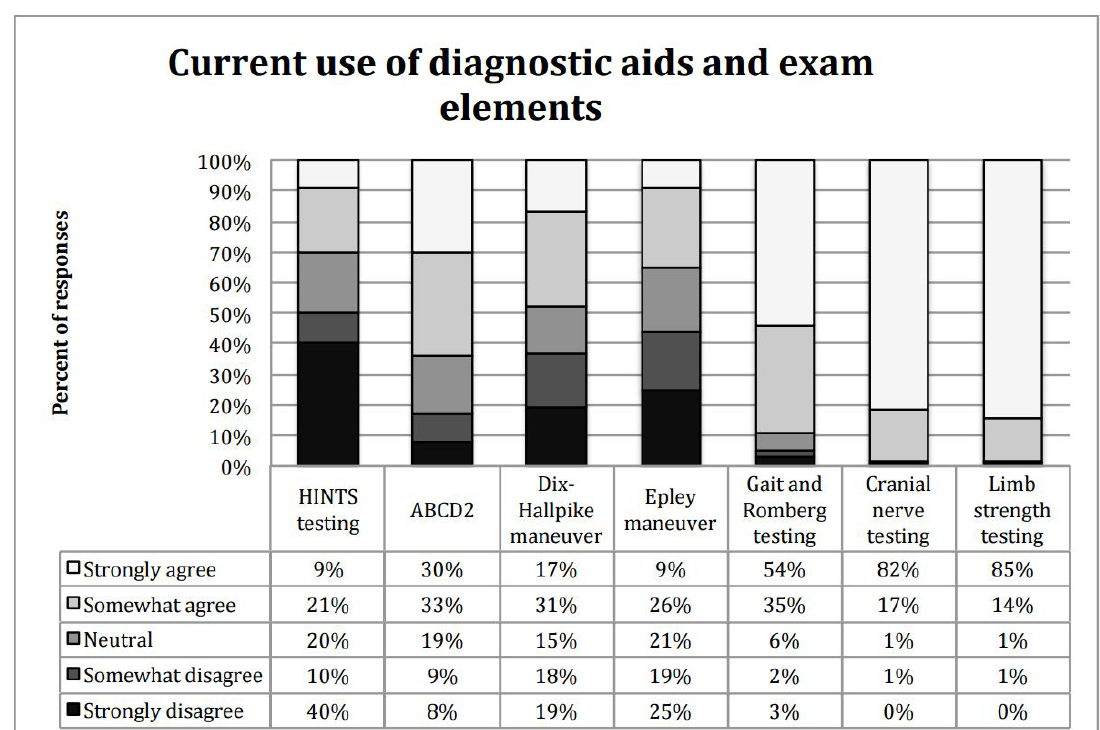
Figure 2. Respondents’ reporting of their perceived current use of bedside tests and clinical prediction rules to evaluate for posterior stroke among emergency department patients with dizziness a.